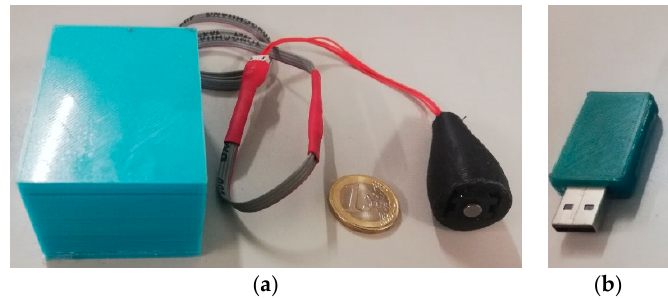
Figure 4. Sensor probe ( a ) with electronics and USB interface ( b ) for wireless communication.